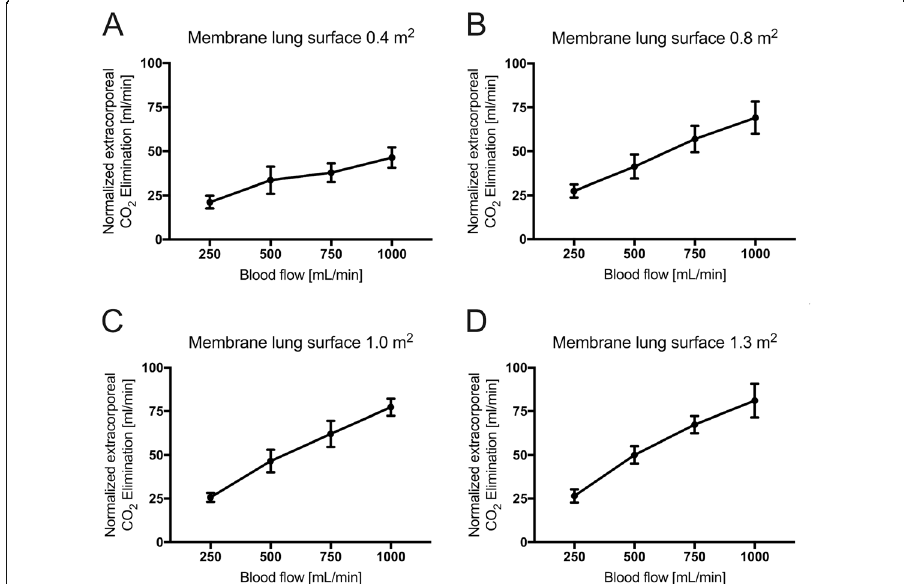
Fig. 2 Normalized extracorporeal elimination of carbon dioxide (CO 2 ) depending on blood flow. Normalized CO 2 removal was calculated by normalizing the partial pressure of carbon dioxide before the membrane lung to 45 mmHg. Membrane lung surface ranges from 0.4 m 2 ( a ), 0.8 m 2 ( b ), 1.0 m 2 ( c ) to 1.3 m2 ( d ) with a sweep gas flow of 8 L O 2 /min. Blood flow was titrated from 250 to 1000 ml/min. Each data point represents the mean and standard deviation of seven